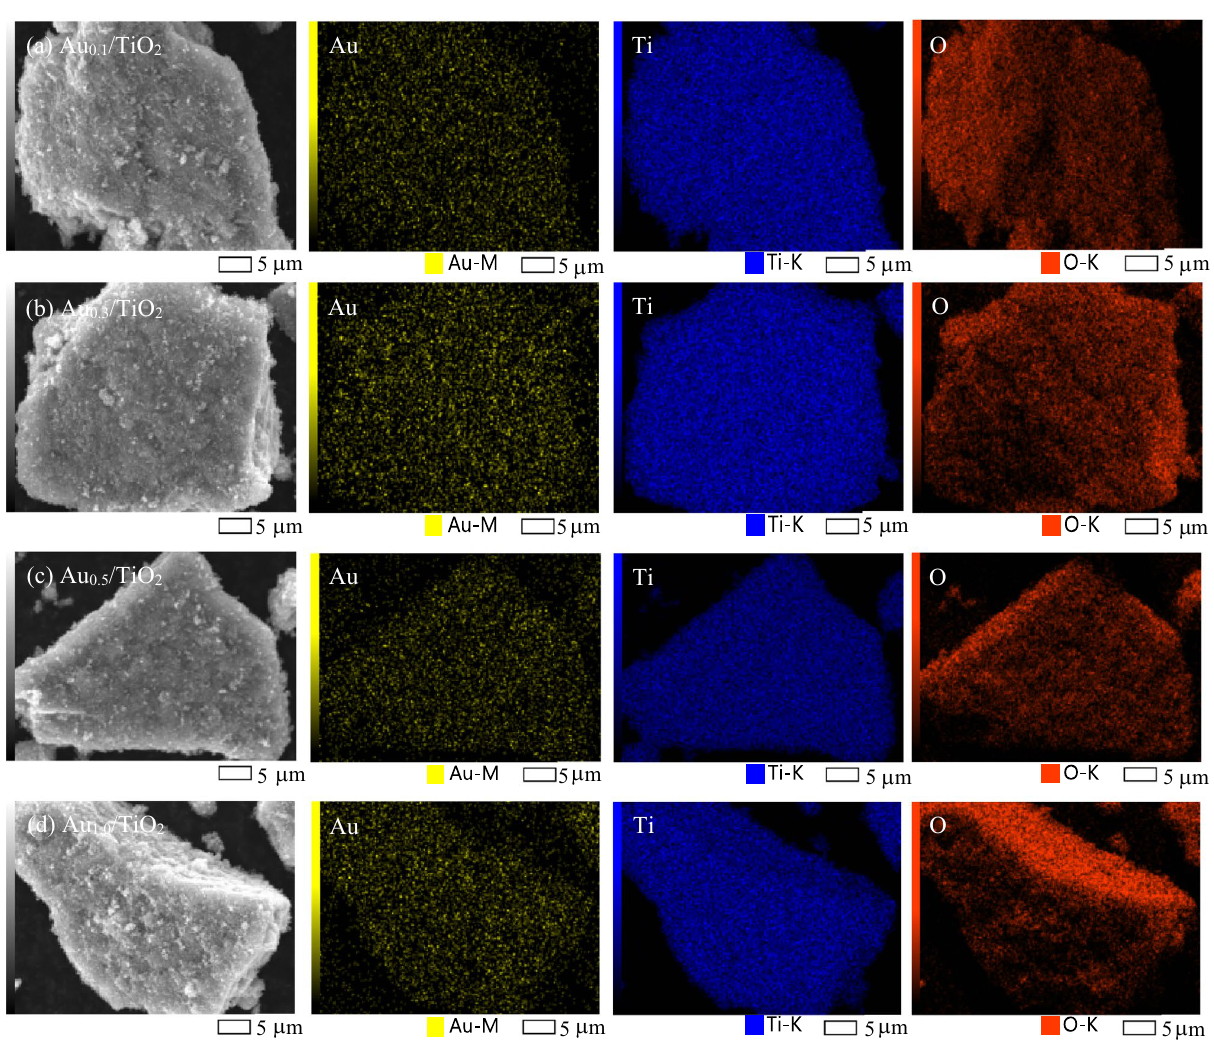
Figure 2. Representative SEM images and EDX element mapping at 3000 × magnification of Au x /TiO 2 NPs synthesized by photodeposition at different gold loadings in the range of 0.1–1.0